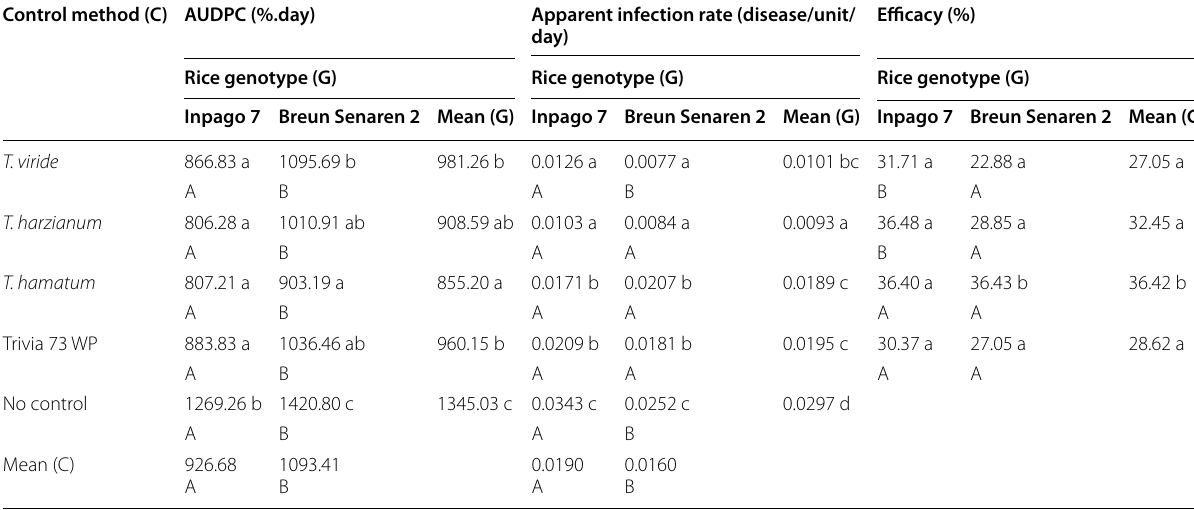
Lowercase denotes comparison within the same column, and uppercase indicates comparison within the same row. Values within the same column/row with the identical lowercase or uppercase are not significantly different based on the LSD (0.05) post hoc test *Determined as the percentage of decrease in AUDPC from that of the control treatment